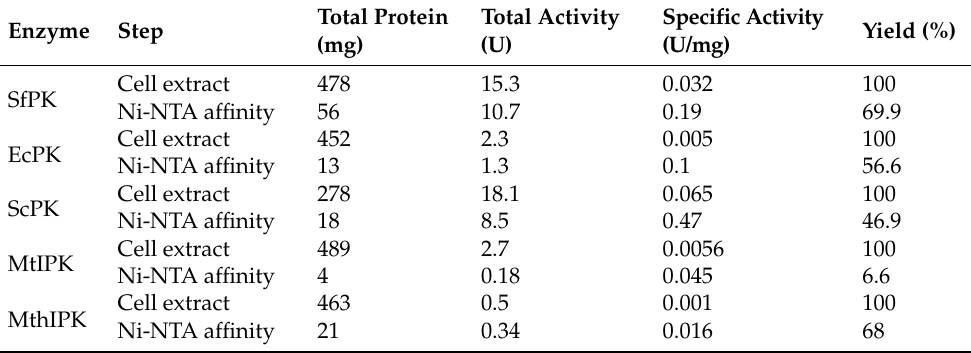
Table 1. Purification of SfPK, EcPK, ScPK, MtIPK, and MthIPK from the recombinant strains.